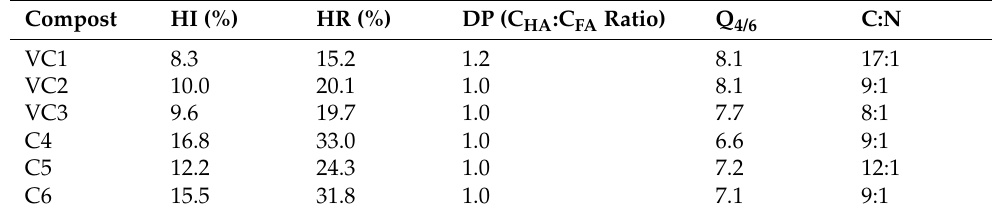
Table 2. The C:N ratio and humification indexes obtained for analyzed vermicomposts and composts.